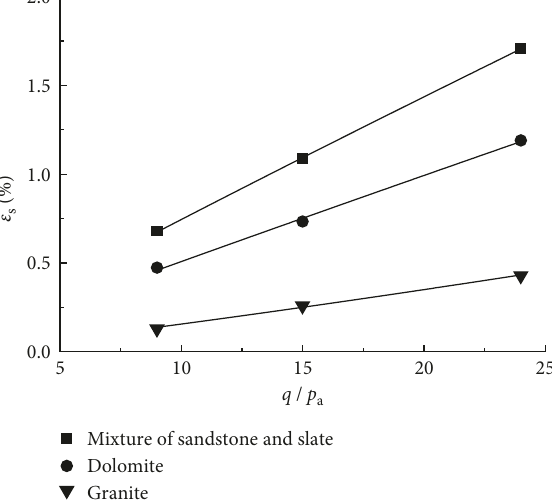
Figure 13: q / p a versus ε s curve (different mother